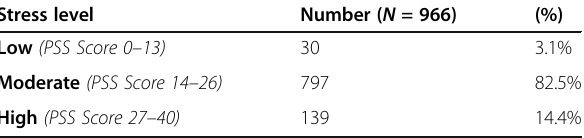
Table 2 Stress among students on PSS 10 scale Stress